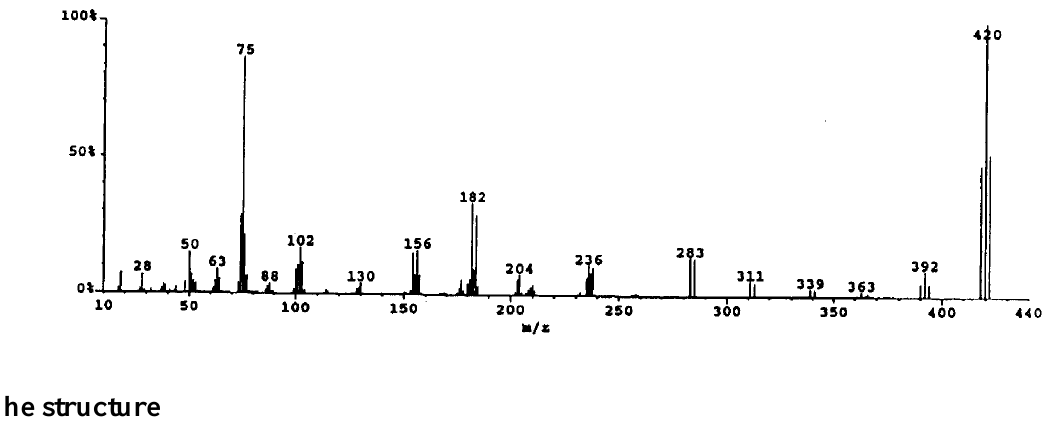
Figure 7. The mass spectrum of 6,6’-dibromoindigo